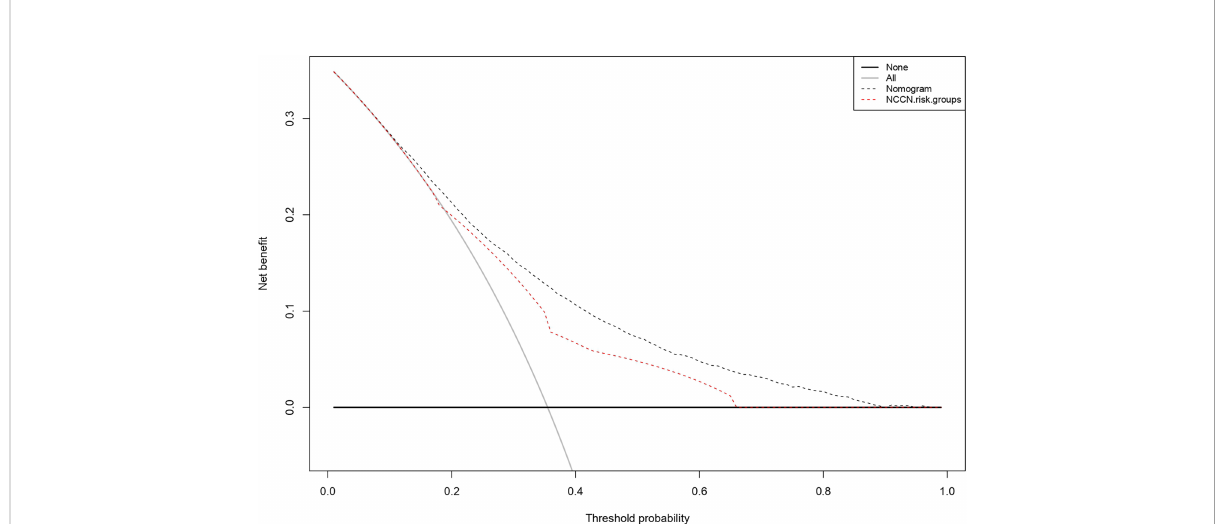
FIGURE 3 Decision curve analyses (DCA) demonstrating the net bene fi t associated with prediction of pT3-4/pN1 with the newly developed model versus a model based NCCN risk group strati fi cation.